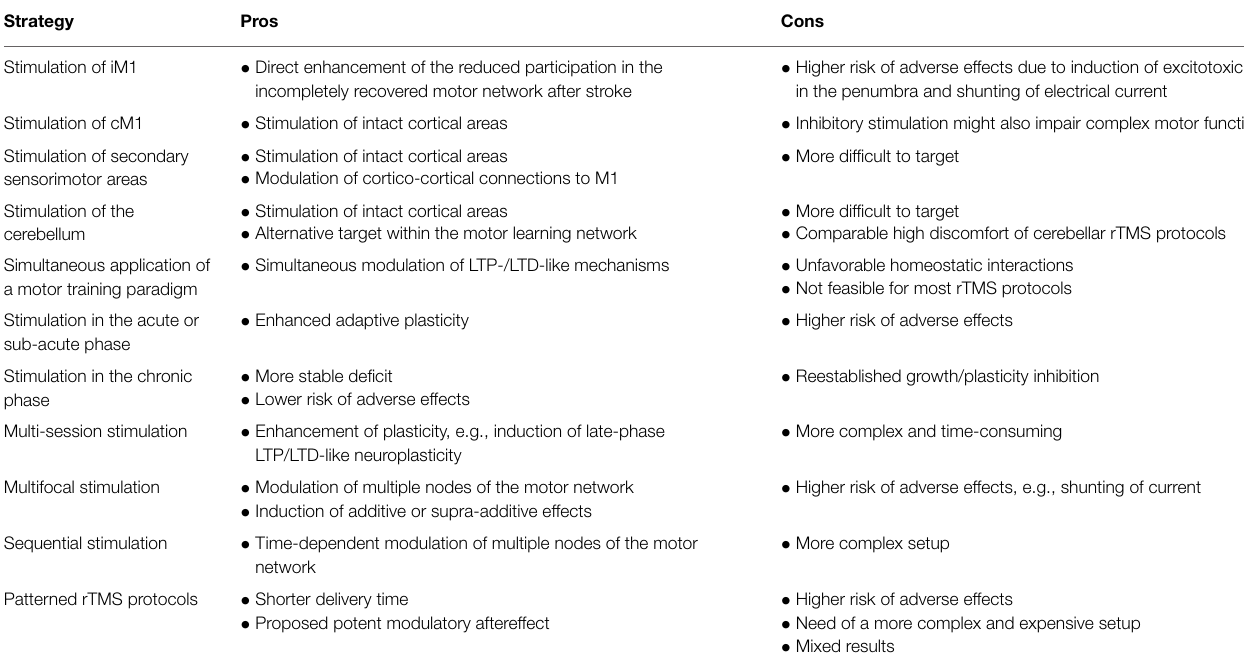
TABLE 2 | Pros and cons of potential strategies for increasing the effect of non-invasive brain stimulation . Strategy Pros Cons Stimulation of